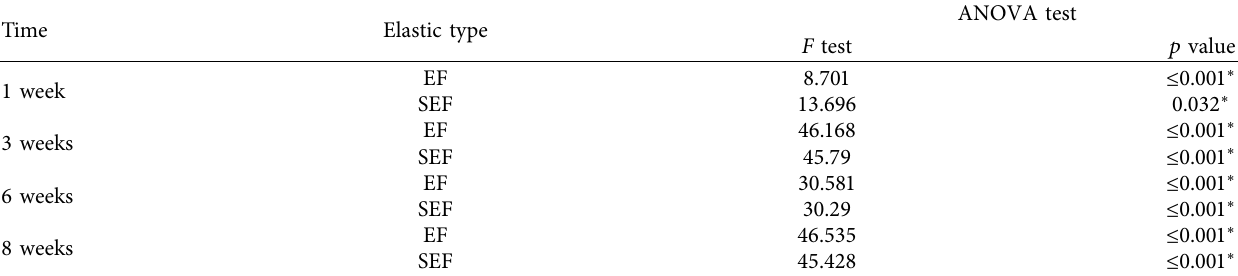
Table 6: Effect of different chemical solutions on Elasto-Force and Super Elasto-Force elastomeric chains.